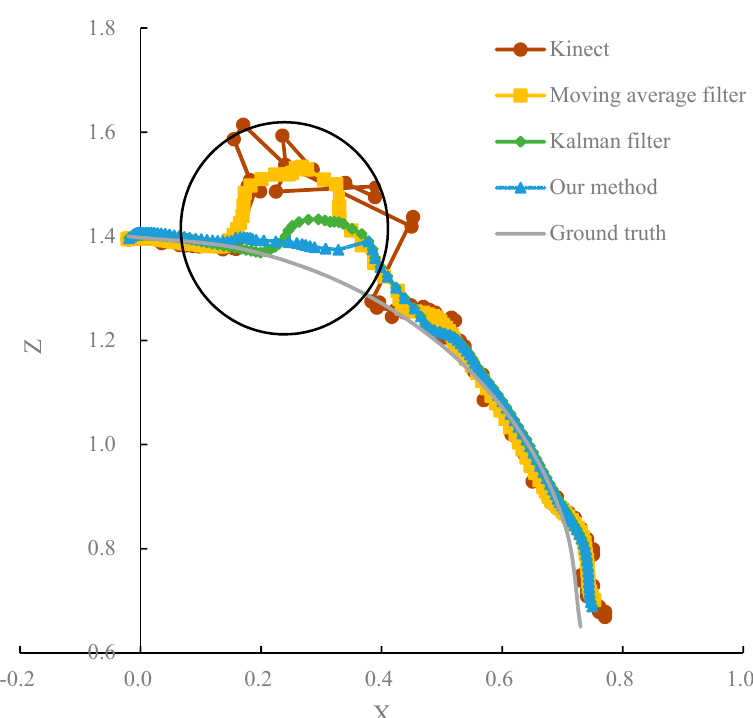
ff erent algorithms and the true Figure 6. Accuracy comparison of different algorithms and the true trajectory. Figure 6. Accuracy comparison of di